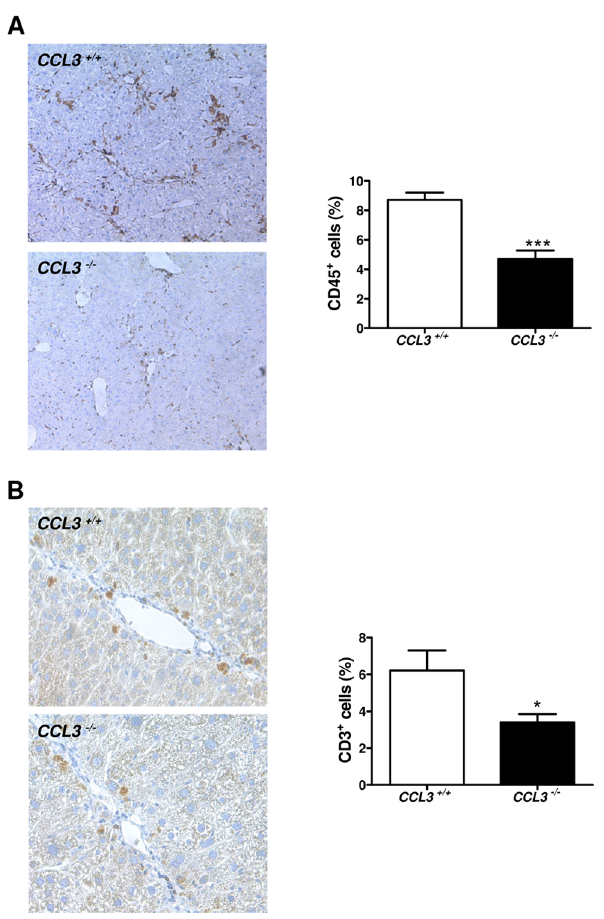
Figure 6. The lack of CCL3 leads to reduced influx of CD45 + and CD3 + cells. CD45 + and CD3 + cell infiltration is markedly reduced in CCL3 2 / 2 mice (x100 magnification, A, x200 magnification, B ). Data are expressed as means 6 SEM of eight mice per group. * P , 0.05, *** P , 0.001.